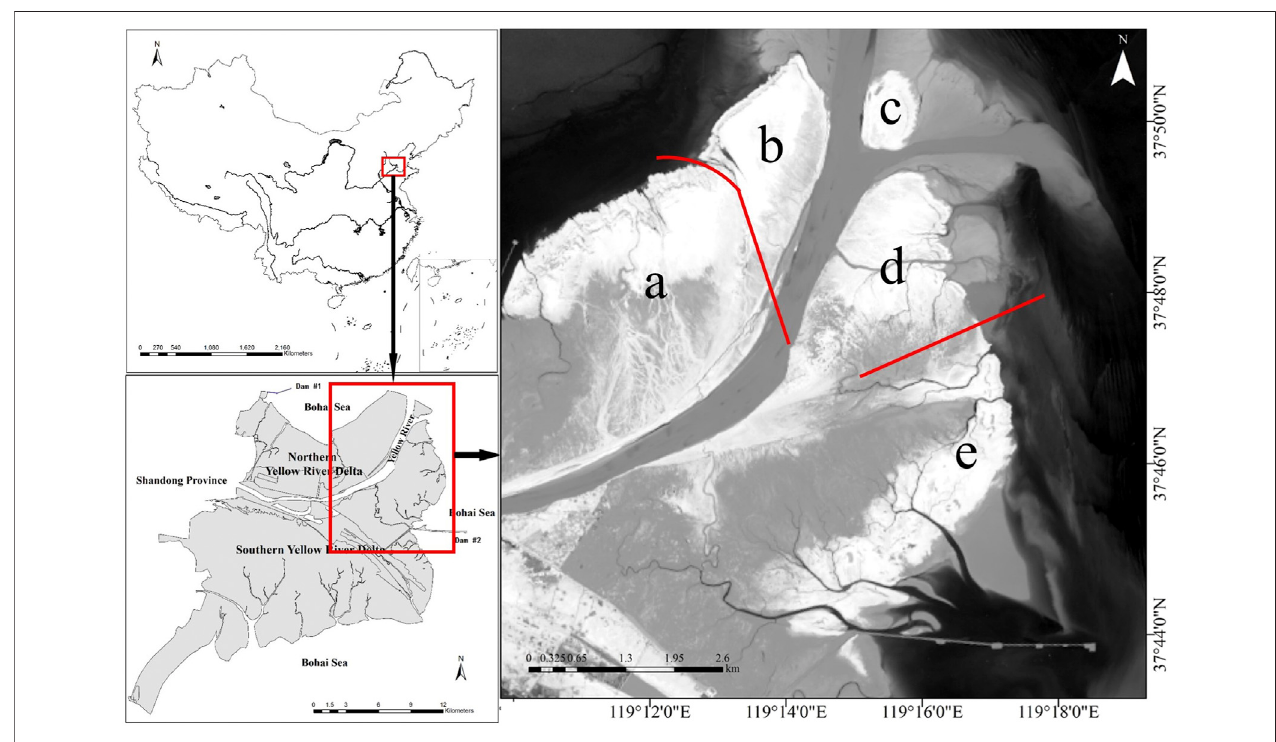
FIGURE 1 | Map of the study